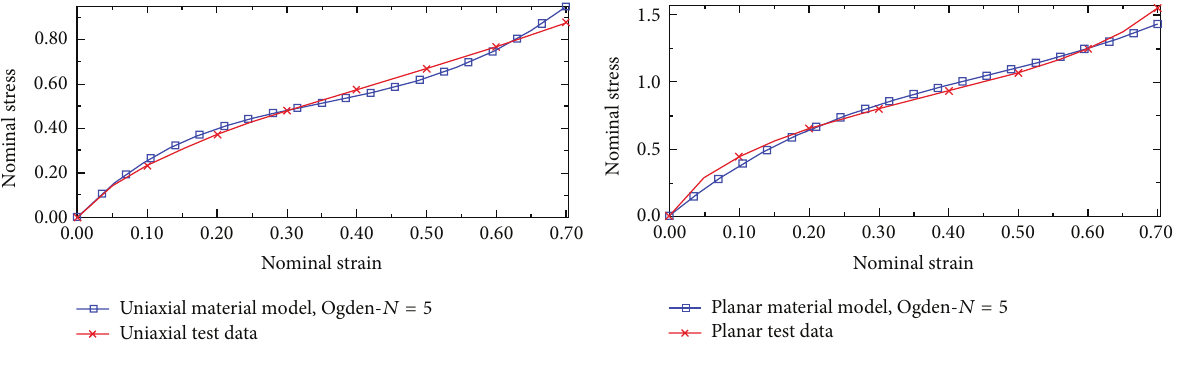
Figure 5: Rubber material for test data (stress-strain curve).